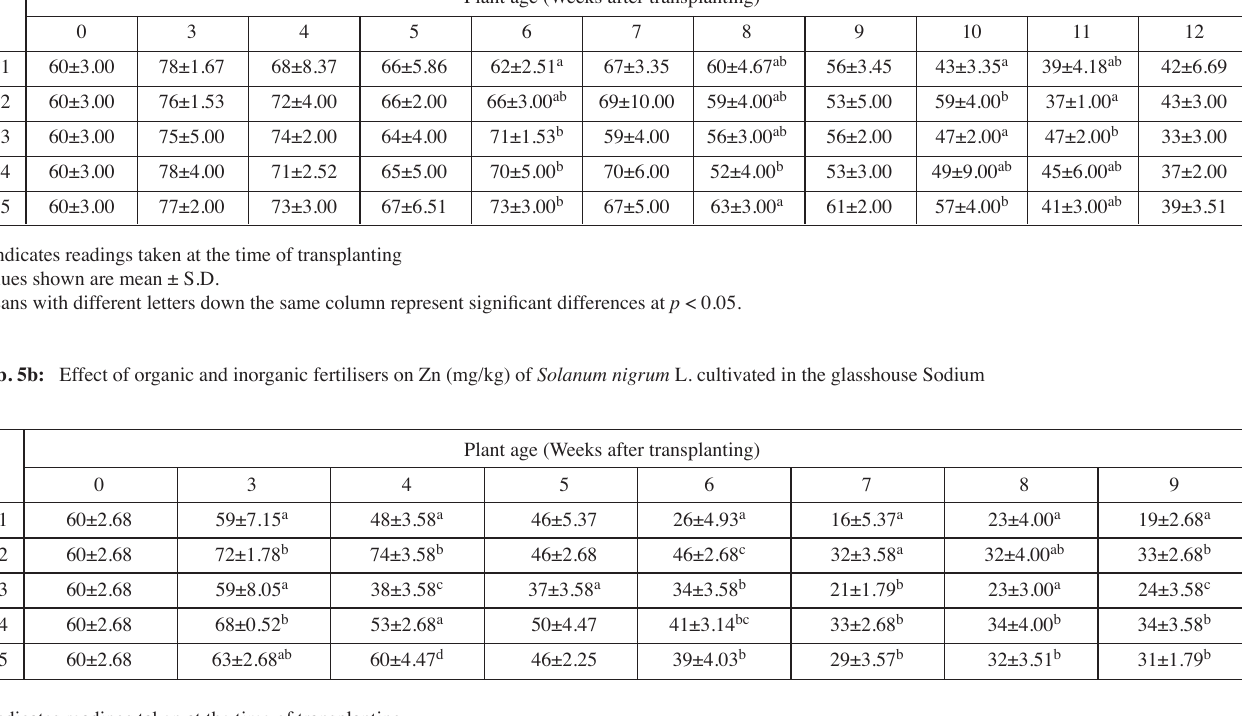
Plant age (Weeks after transplanting)